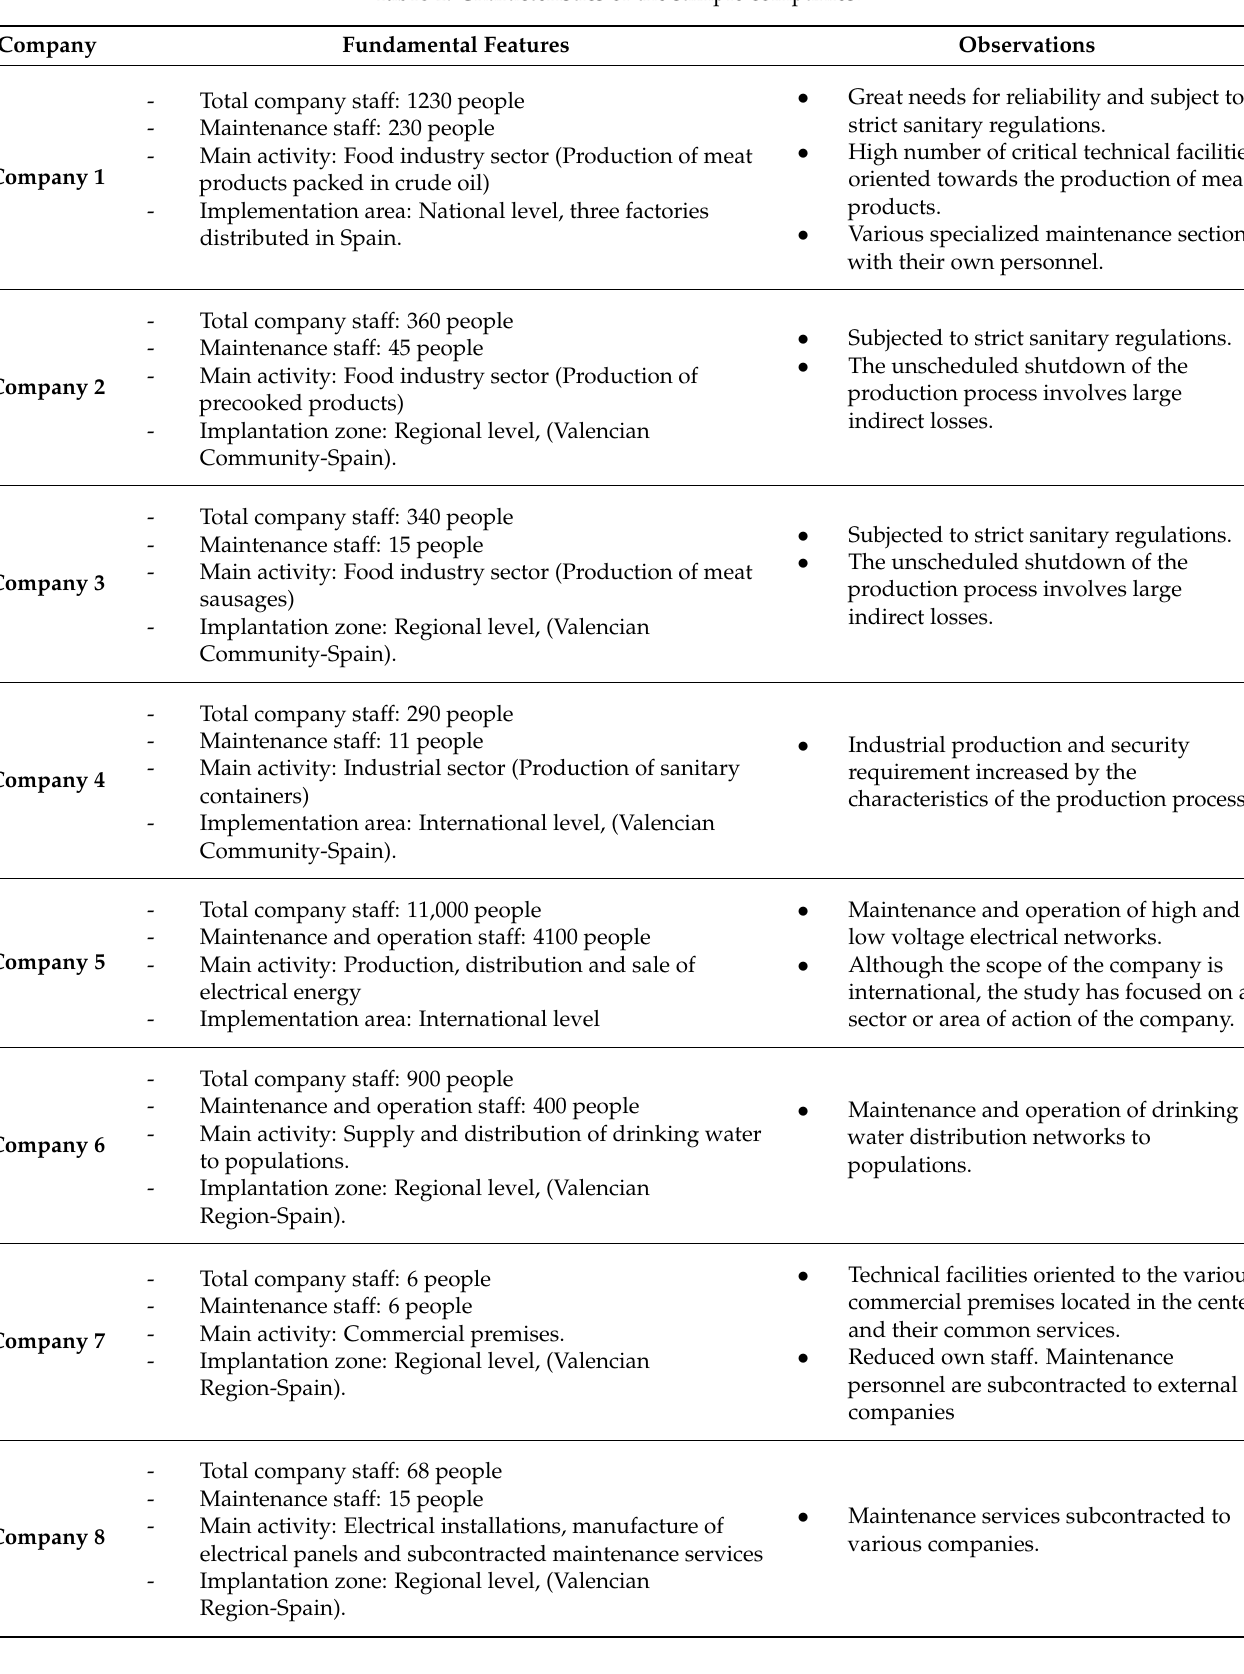
Table 1. Characteristics of the sample